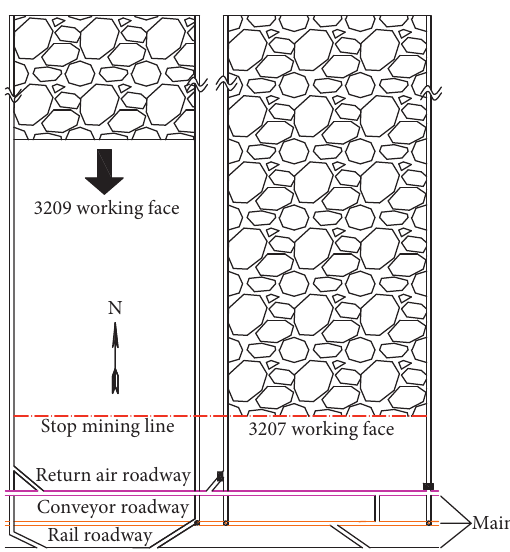
Figure 1: Layout of main roadways and mining faces.